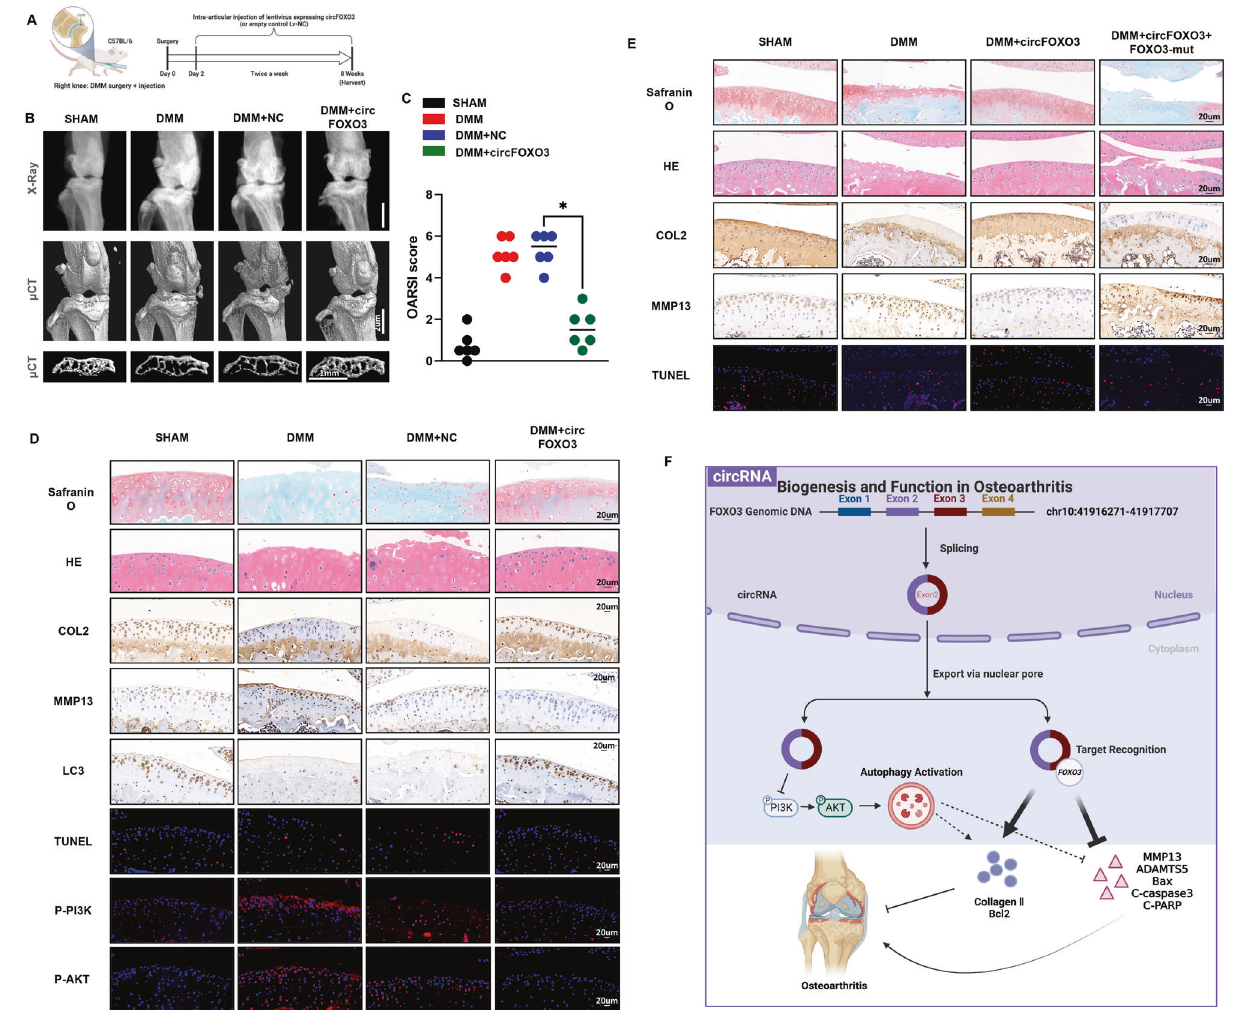
Fig. 7 Gene therapy with circFOXO3 preserves articular cartilage integrity in a mouse OA model. A Schematic of the animal experiments (for each group, n = 6, C57BL/6). B X-ray and 3D reconstruction images of micro- CT scanning of the knees. Scale bars, 2 mm and 1 mm. C OARSI scoring was performed according to staining results. ( n = 6) * p < 0.05. D Safranin-O/fast green staining, H&E staining, TUNEL staining, IHC staining and IF staining of cartilage from different groups. Scale bars, 20 μ m. E Safranin-O/fast green staining, H&E staining, TUNEL staining and IHC staining of cartilage from different groups. Scale bars, 20 μ m. F Graphic abstract of our